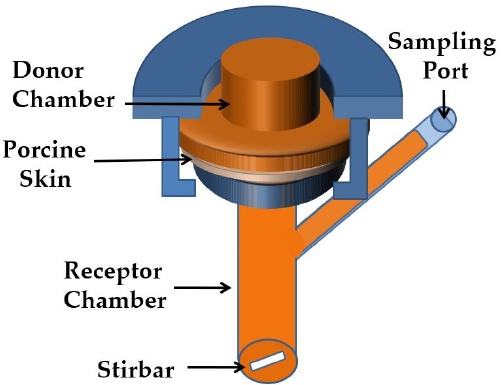
Figure 1. Schematic illustration of unjacketed Franz diffusion cell.